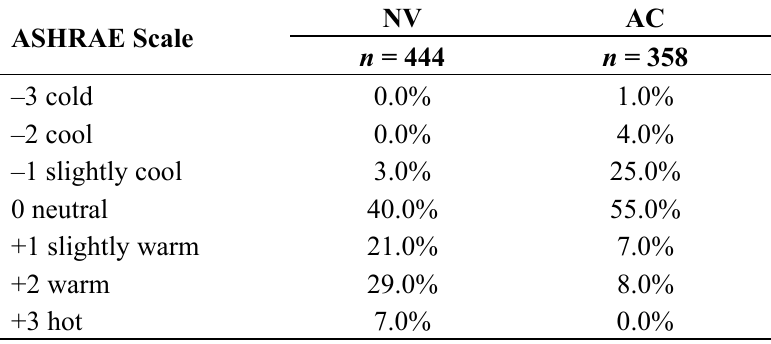
Table 5. Perception of indoor climate by occupants of